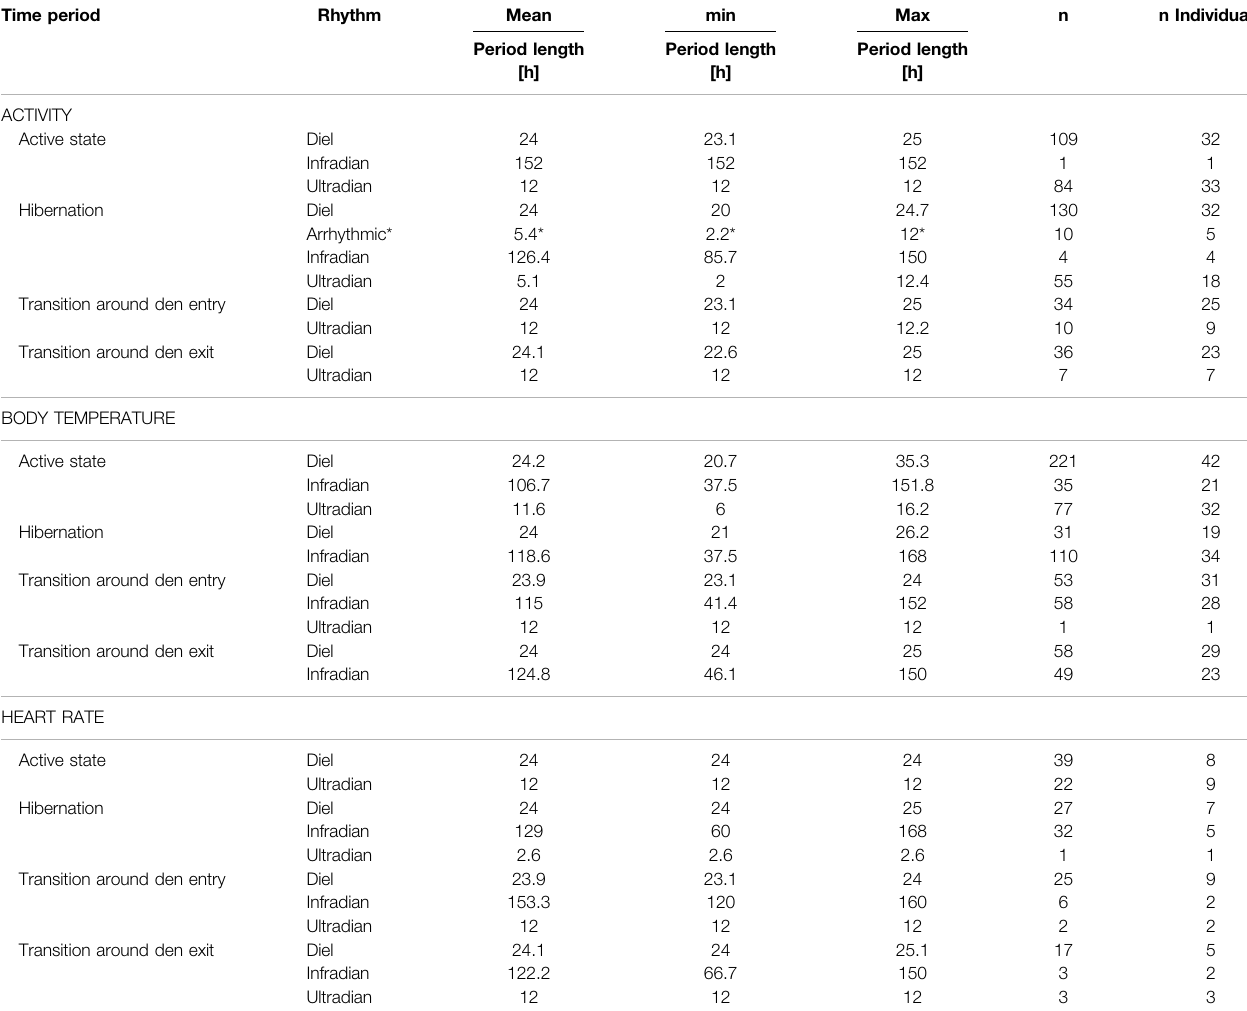
TABLE3| Average(mean),minimum(min)andmaximum(max)periodlengths[hours]andsamplesizeofobservations(n)andsampleofindividuals(nIndividuals)ofrhythms in activity, body temperature and heart rate in Scandinavian brown bears based on time period (active period, hibernation, transition state around den entry and exit). *Arrythmic rhythms, highest peaks in the Lomb-Scargle Periodogram without a signi fi cant signal. Time period